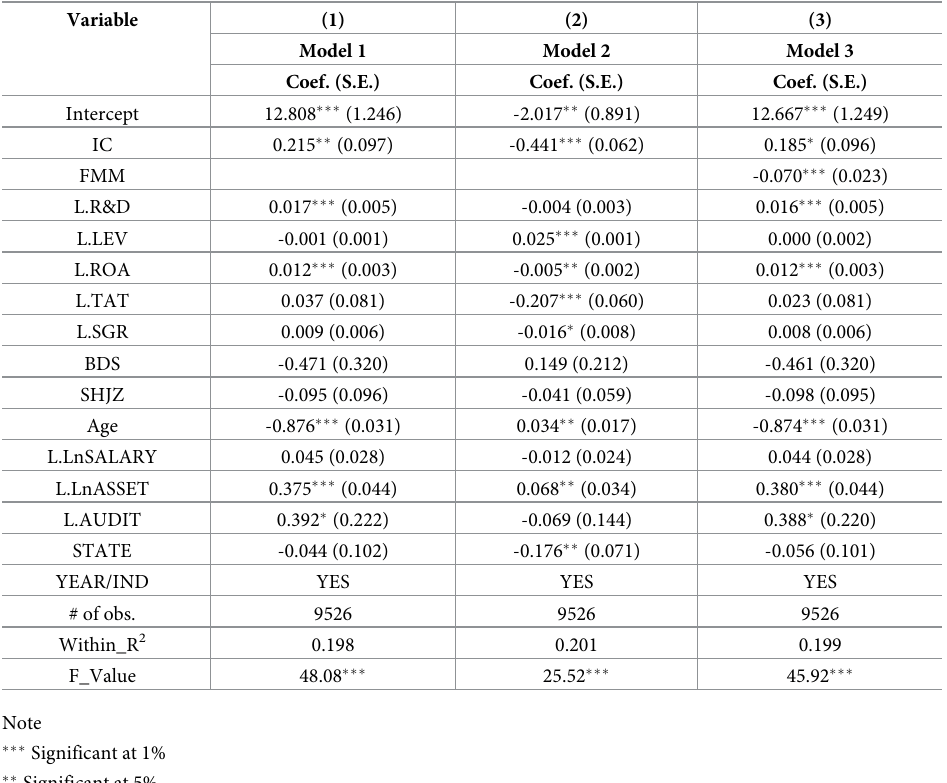
Table 9. Regression results based on PSM